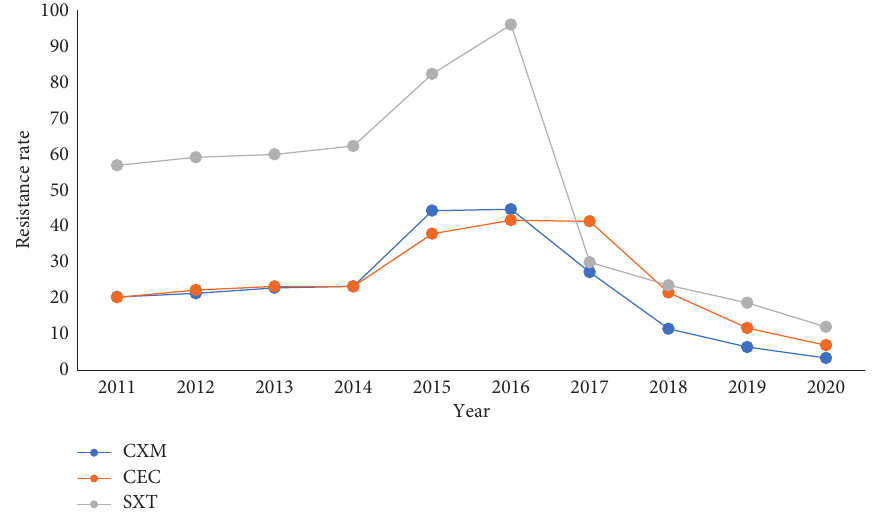
Figure 18: Change in drug resistance of M. catarrhalis from 2011 to 2020 (%).